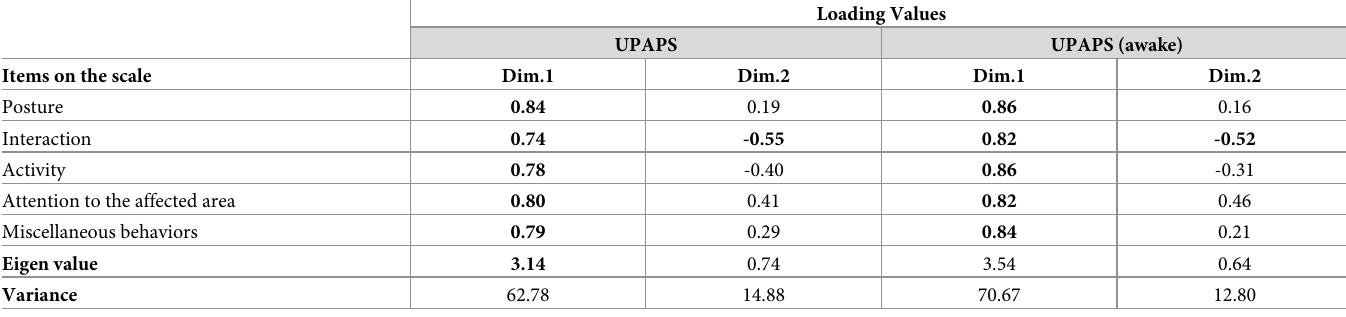
Table 4. Loading values, eigenvalues and variance of the UPAPS items applied to castrated piglets (n = 39) and castrated piglets awake (n = 14) based on principal components analysis.